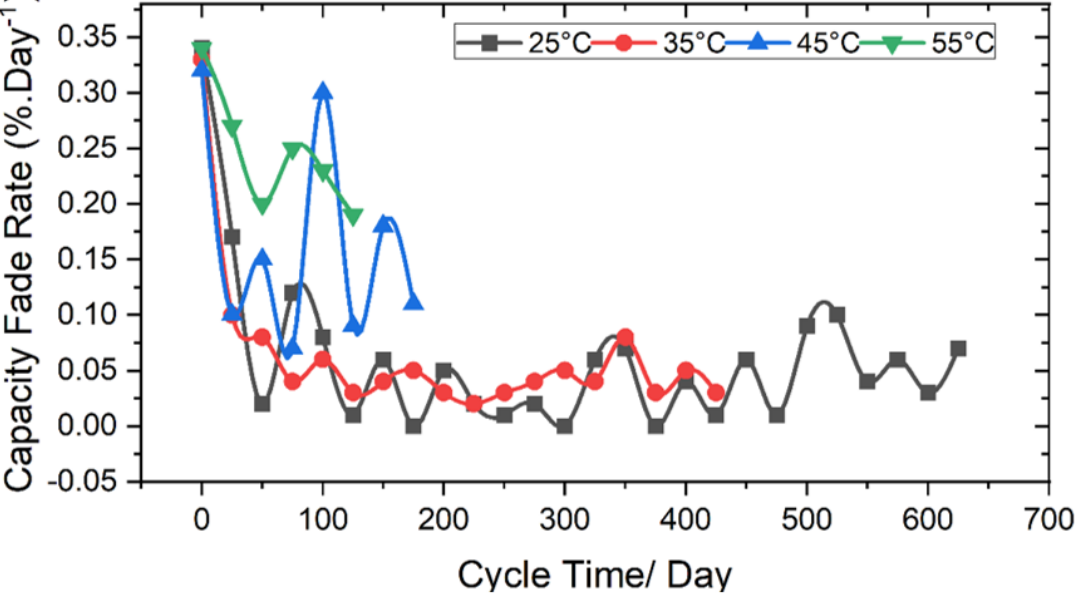
Figure 10. Capacity fade rate of LiFePO 4 battery at each temperature during cycling [100].